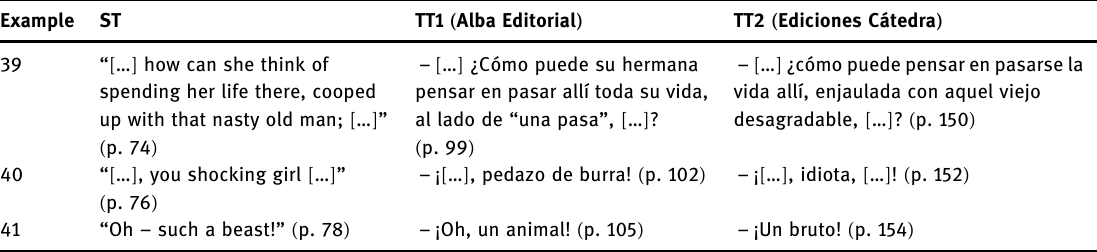
Table 8: Examples taken from Chapters 8 and 9 Example ST